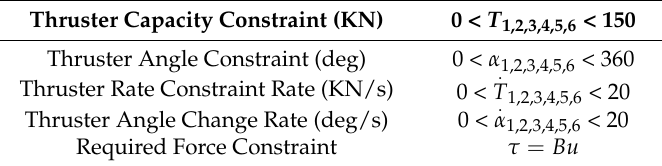
Table 8. Thruster Constraints.